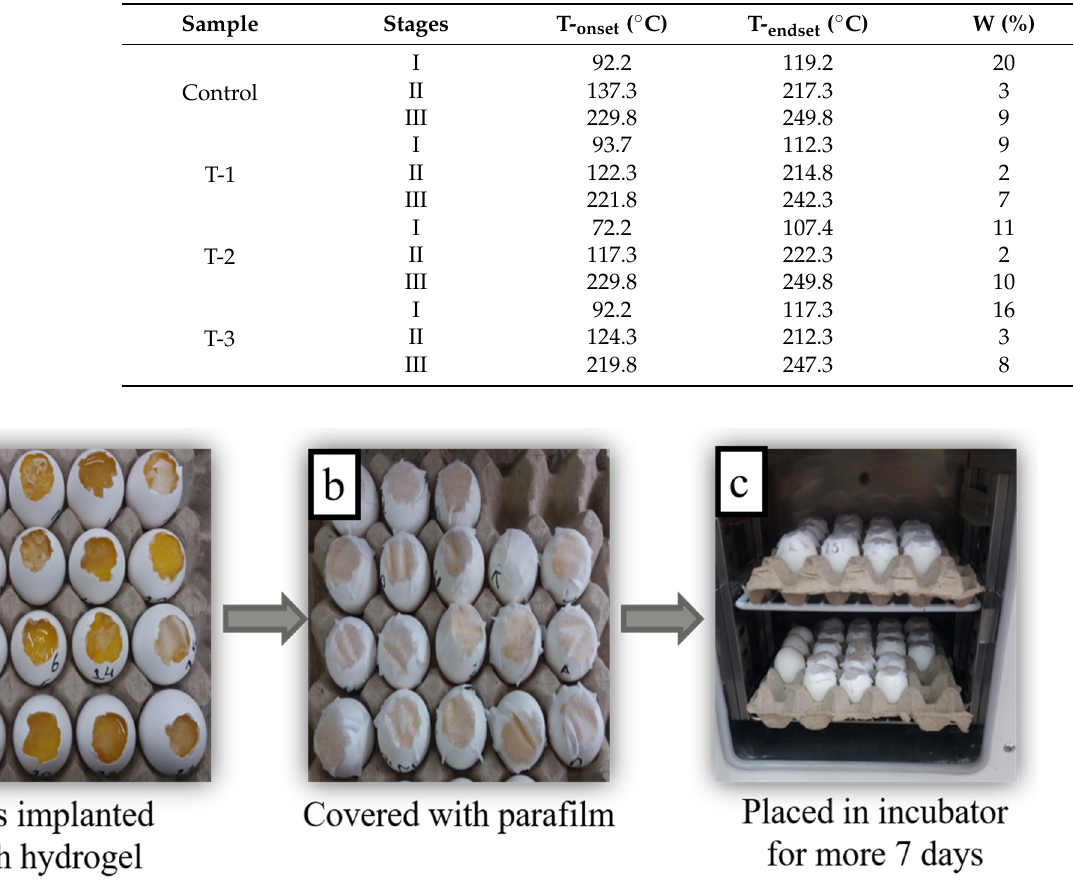
Figure 5. Stepwise handling of chick eggs at day 7.